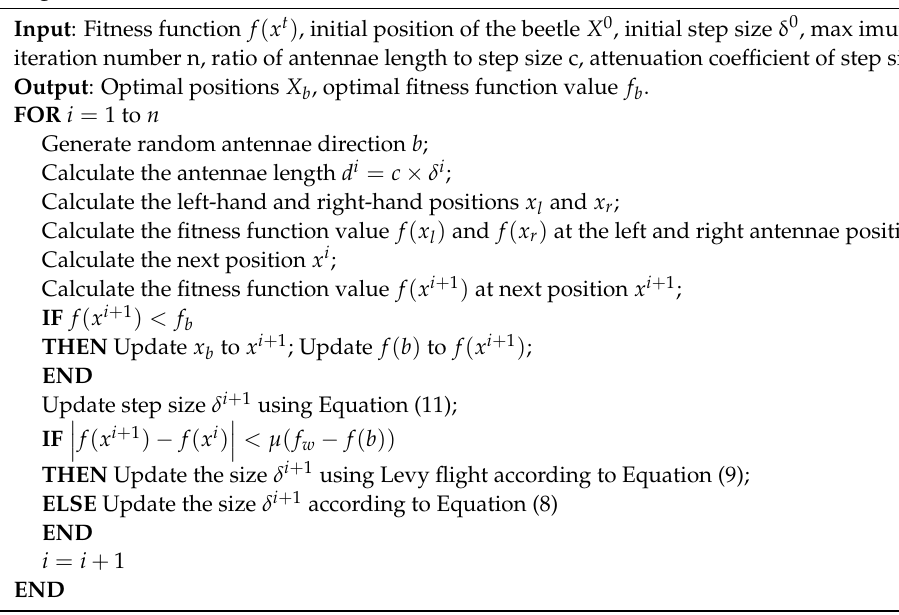
Algorithm 1 : Modified